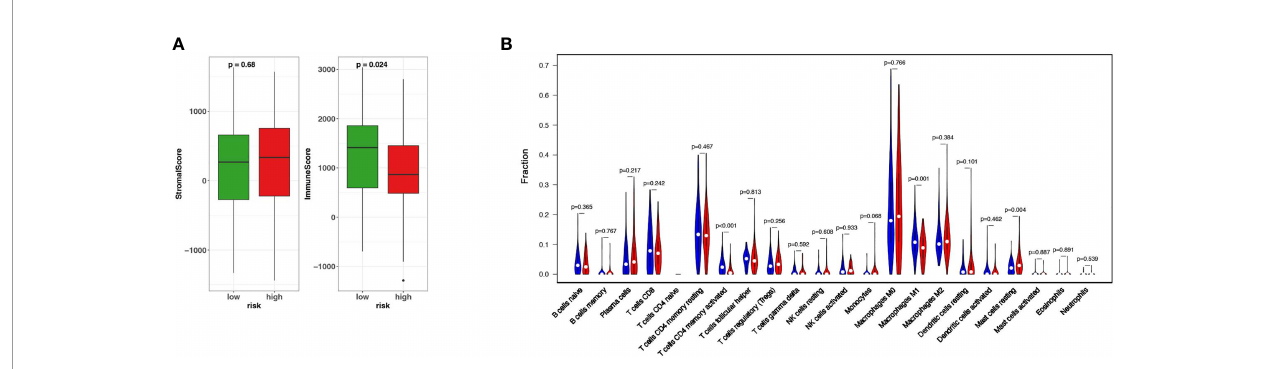
FIGURE 4 | Different immune microenvironment between HR and LR TNBC patients. (A) The fraction of stromal and immune cells in HR and LR groups. (B) The Vioplot shows that the abundances of T cells CD4 memory activated, macrophages M1 (P < 0.01), and mast cells resting(P < 0.05) were signi fi cantly different between HR and LR.